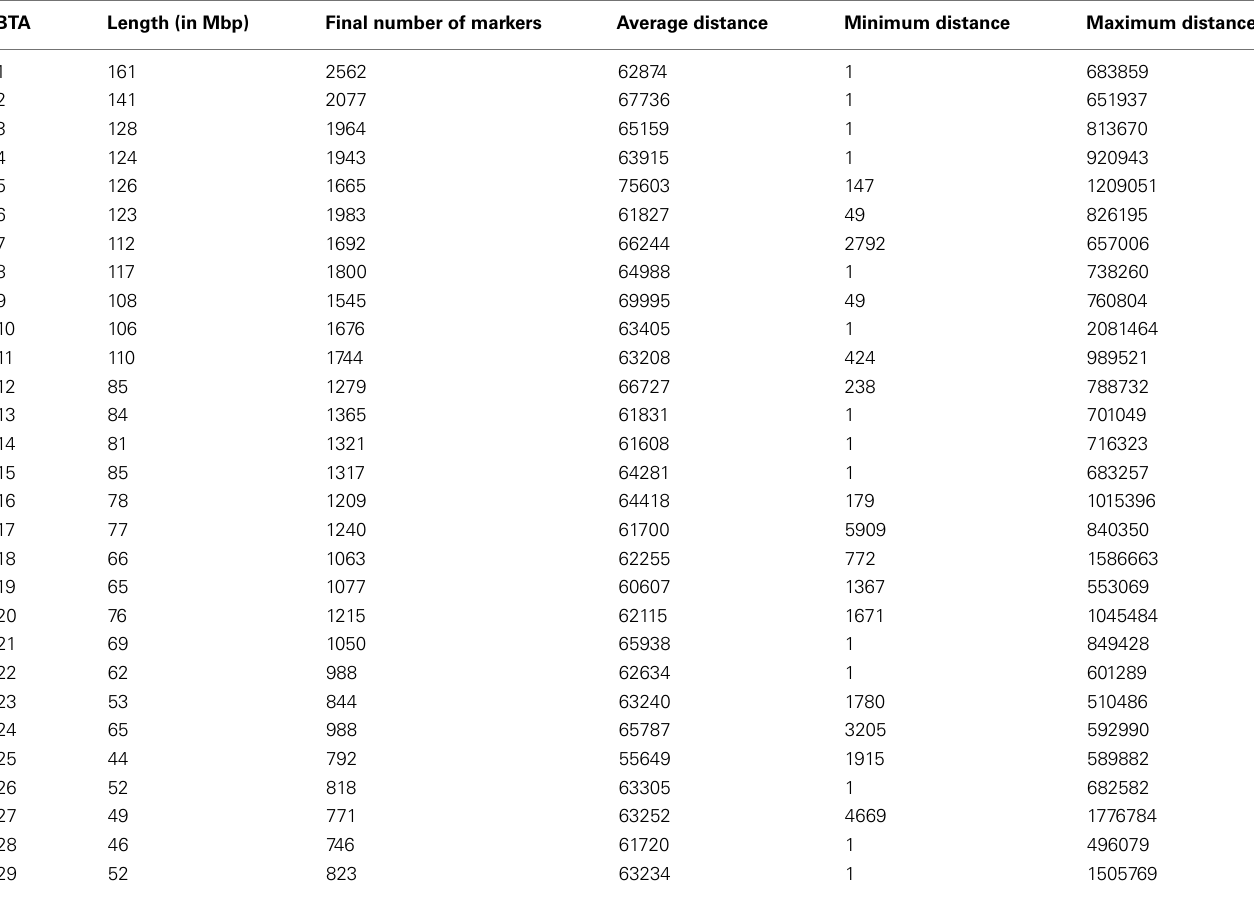
Table 1 | Numbers of markers and inter-marker distances (in base-pair) across chromosomes.